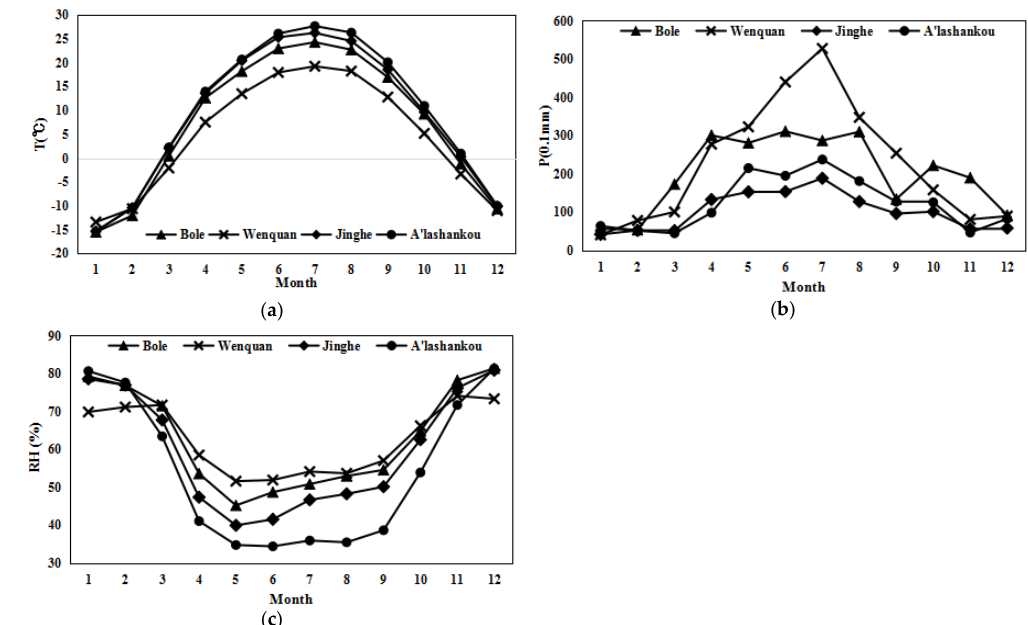
Figure 15. Monthly mean temperature ( a ), precipitation ( b ), and relative humidity (( c ), RH) change based on the data of four meteorological stations across study area from 2000 – 2016 (Bole Station: 2009 – 2016).